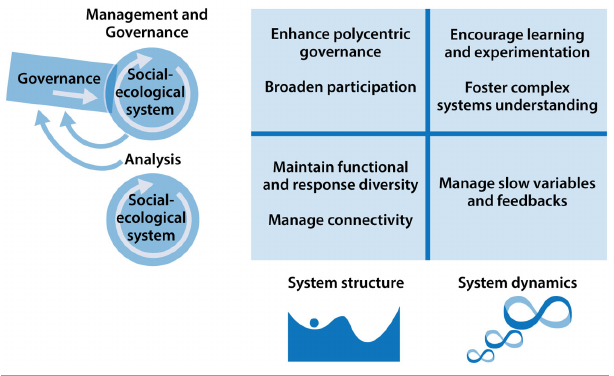
Fig. 2 . Principles for enhancing resilience in relation to the structure and dynamics of social-ecological systems and their analysis and management and governance (modified from Quinlan et al.